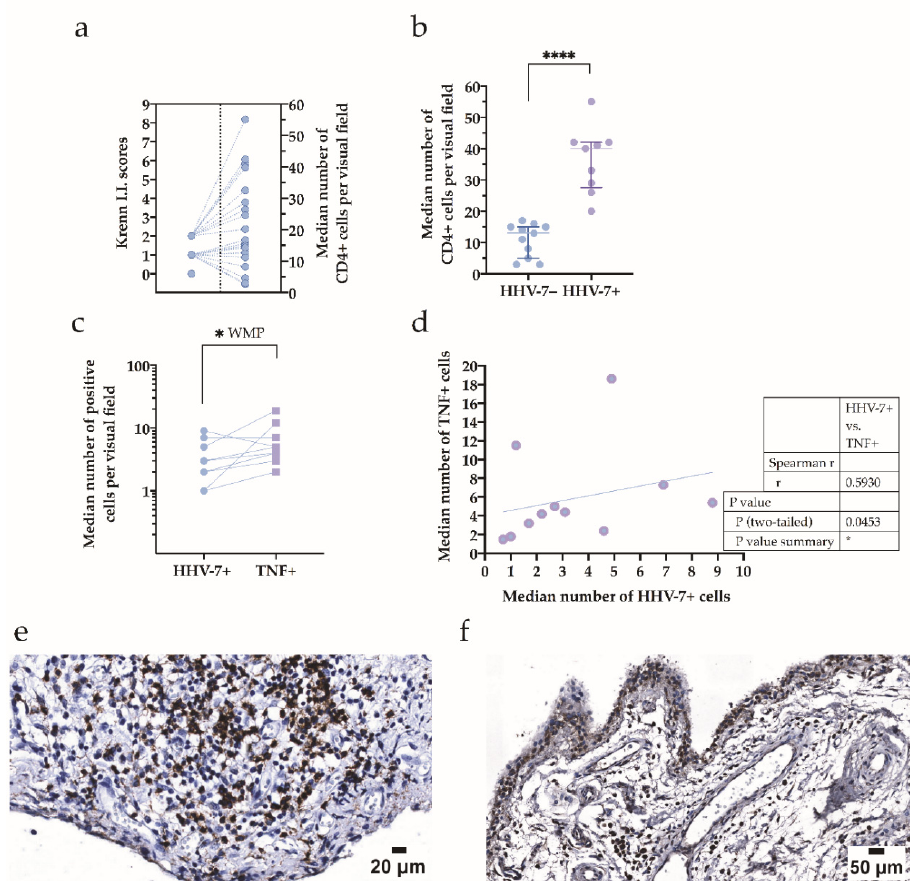
Figure 4. Assessment of synovial CD4-positive lymphocytes and TNF-positive cells in both study groups—HHV-7 PCR+ and HHV-7 PCR − —and HHV-7-positive cells in the HHV-7 PCR+ group. ( a